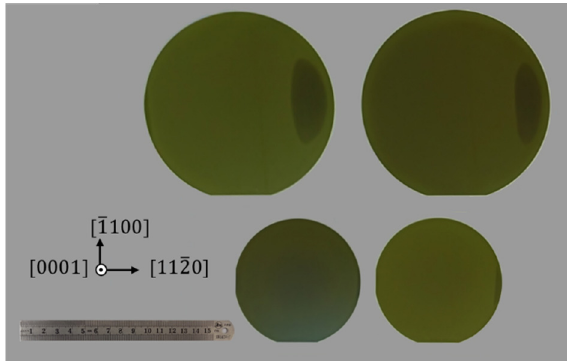
Figure 2. Images of 4H-SiC epitaxial wafer.